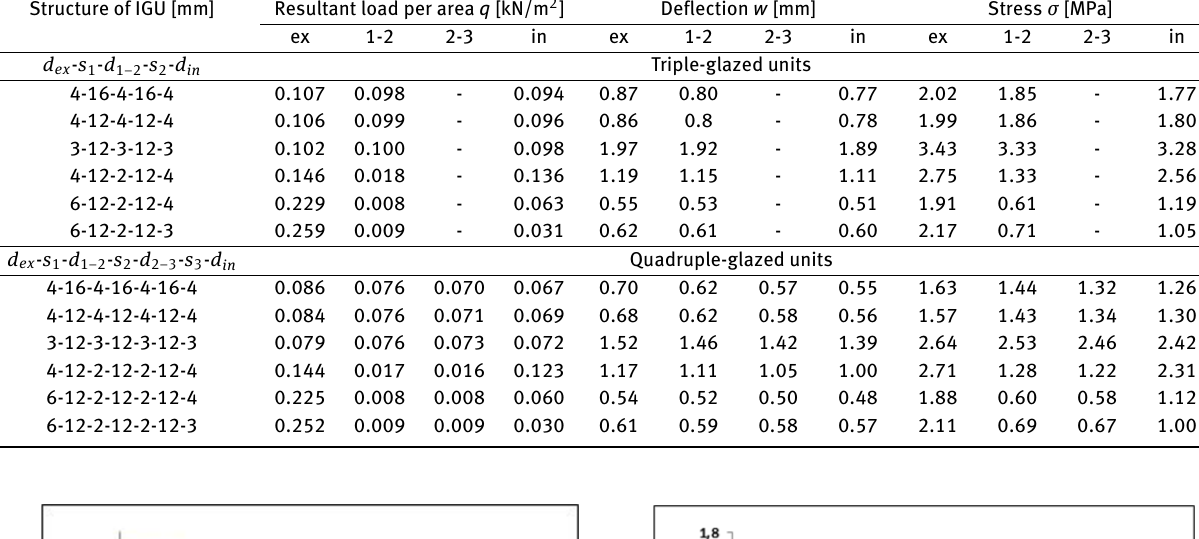
Table 3: Static values in component glass panes - load “wind from the left” 0.3 kN/m 2 . Structure of IGU [mm]